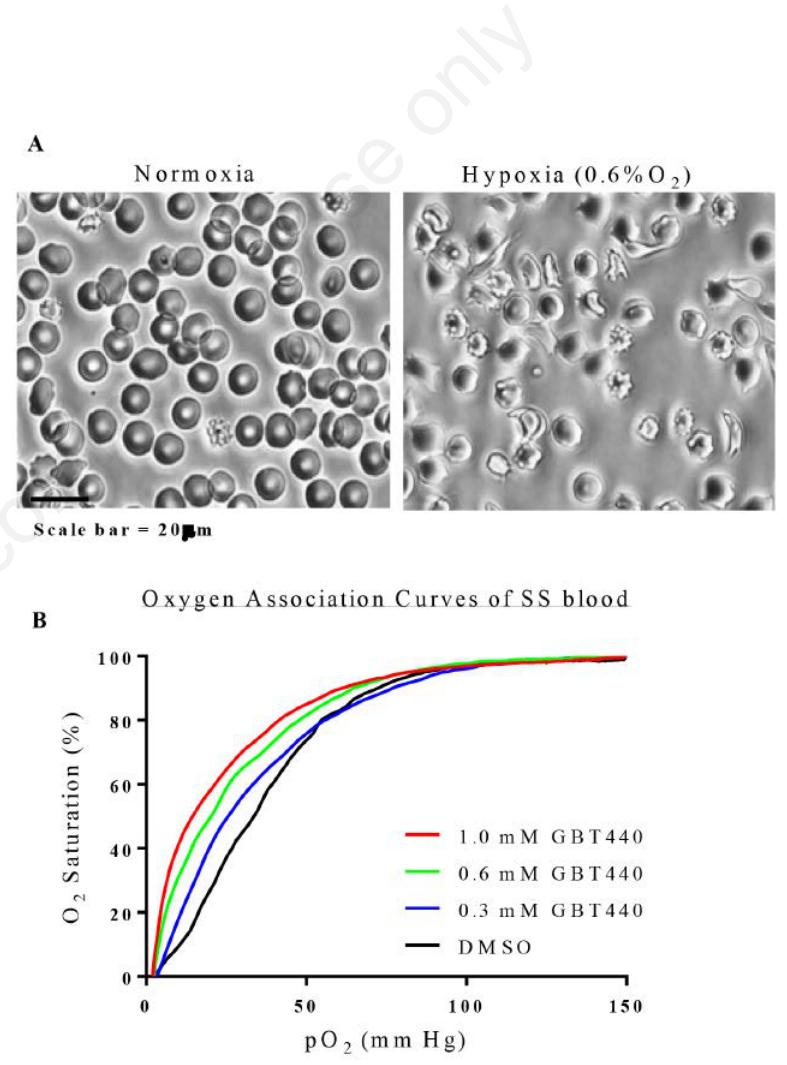
Figure 2. GBT440 modifies polymerized HbS in sickled SS RBCs. (A) Representative images of SS RBCs at room air (normoxia; left panel) and at 0.6% O 2 (hypoxia; right panel), respectively. Solid black line represents the scale of the images (B) Oxygen asso- ciation curves of sickled blood (containing SS RBCs with polymerized HbS) treated with GBT440 in